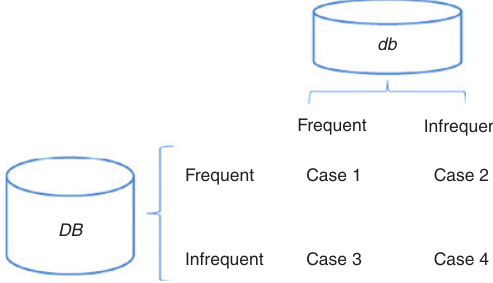
Figure 3: Possible Cases in Incremental